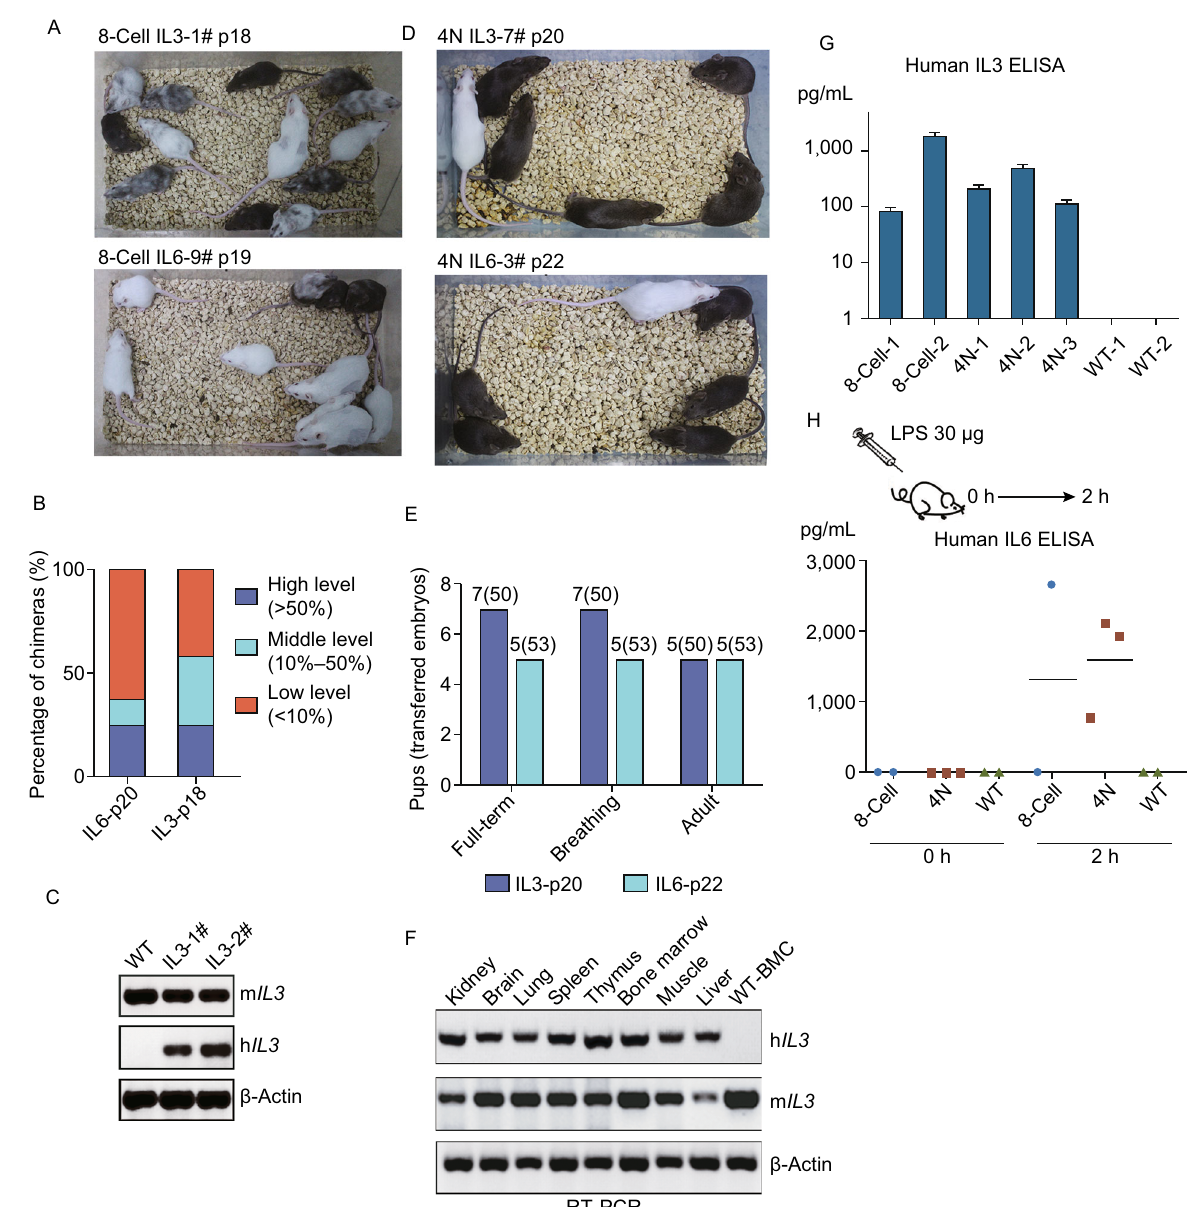
Figure 4. Analysis of IL3 and IL6 8-cell- and tetraploid-derived mice. (A) Chimeras generated by injecting IL3 or IL6 EPS cells into 8-cell embryos. Cells were injected into 8-cell embryos at the indicated passage. (B) Bar chart shows the percentage of chimeras generated by 8-cell embryo injection. (C) RT-PCR analysis of human IL3 (h IL3 ) and mouse Il3 (m IL3 ) expression in bone marrow cells isolated from chimeras generated by 8-cell embryo injection. The negative-control cells were collected from wild-type mice. (D) Representative images showing IL3 - or IL6 -targeted EPS cell-derived mice through tetraploid complementation. Cells were injected into tetraploid blastocysts at the indicated passage. (E) Bar chart shows the proportion of full-term, breathing, adult mice derived from transferred embryos in the tetraploid complementation assay. (F) RT-PCR analysis of h IL3 and m IL3 expression in different tissues of IL3 -targeted EPS cell-derived tetraploid mice. (G) ELISA measurement of hIL3 expression in peripheral blood isolated from chimeras generated by 8-cell embryo injection of IL3 -targeted EPS cells (8-cell-1 and 8-cell-2), as well as IL3 -targeted EPS cell-derived mice by tetraploid complementation (4n − 1, 4n − 2 and 4n − 3). The negative control was wild-type ICR mice. Error bars indicate SEM ( n = 3). Data were analyzed by t -test. (H) ELISA measurement of human IL6 expression in peripheral blood from chimeras generated by 8-cell embryo injection of IL6 -targeted EPS cells (8-cell), as well as IL6 -targeted EPS cell-derived mice by tetraploid complementation (4N). LPS was used to stimulate human IL6 secretion. Each mouse was treated by 30 μ g LPS, and peripheral blood was collected after 2 h. Each dot represents 1 mouse. Horizontal bars indicate mean